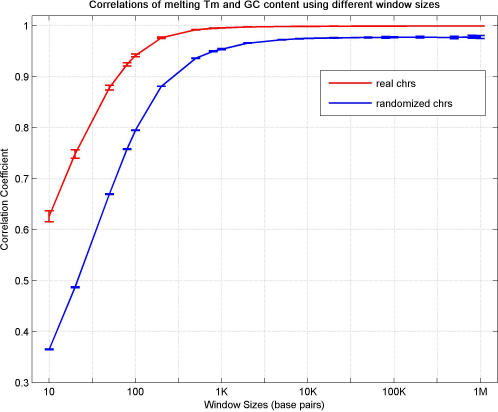
Correlations of Melting Temperature (Tm) with G + C ContentThe correlation coefficients between GC content and Tm are plotted as a function of window sizes. For each chromosome, excluding the segments which contain unknown bases (N's), the correlation coefficient was calculated from all pairs of GC content and average Tm over all nonoverlapping segments of a given window size. Across the chromosomes, the average correlation coefficients and SDs were calculated for each window size. The figure shows the average correlations with SDs (error bars) for window sizes from 10 bp to 1 Mbp for the human chromosomes (red) and the randomized chromosomes (blue).